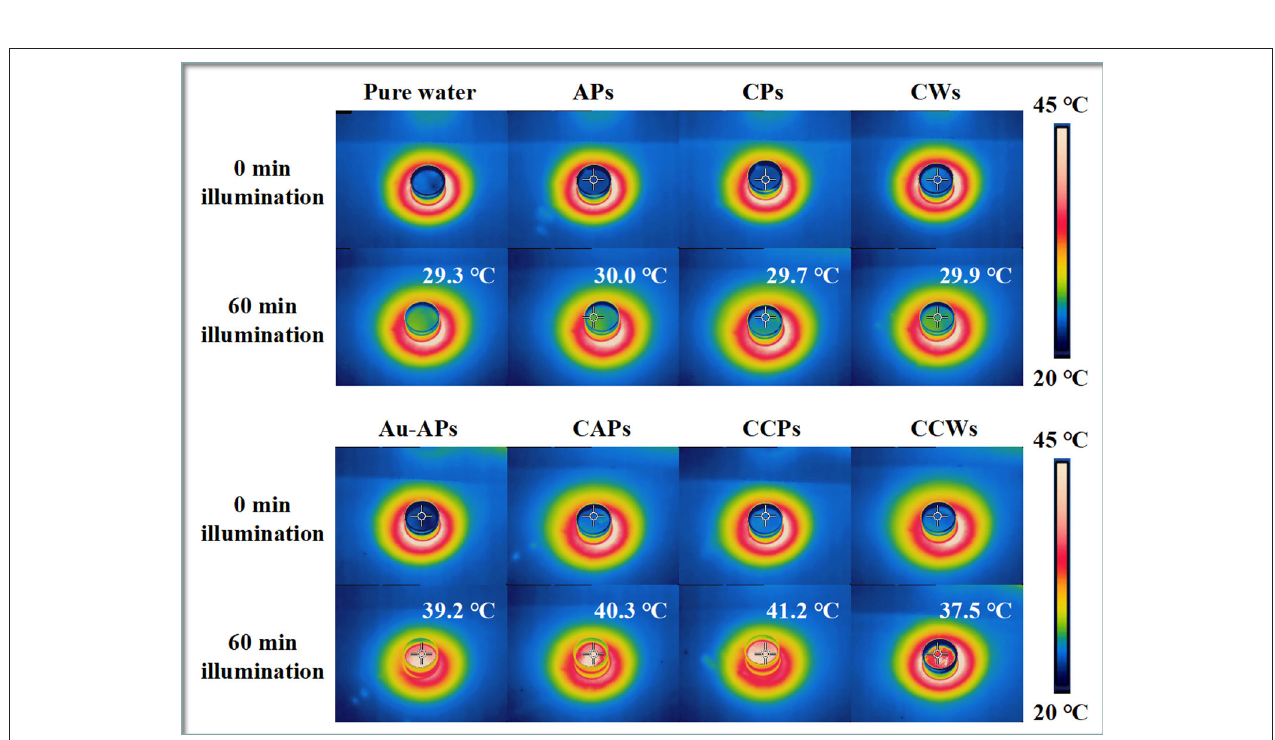
FIGURE 4 | The IR images of temperature changes for the pure water, Au-APs, APs, CAPs, CPs, CCPs, CWs, and CCWs (with water immersion) under 1 sun illumination within 1h.